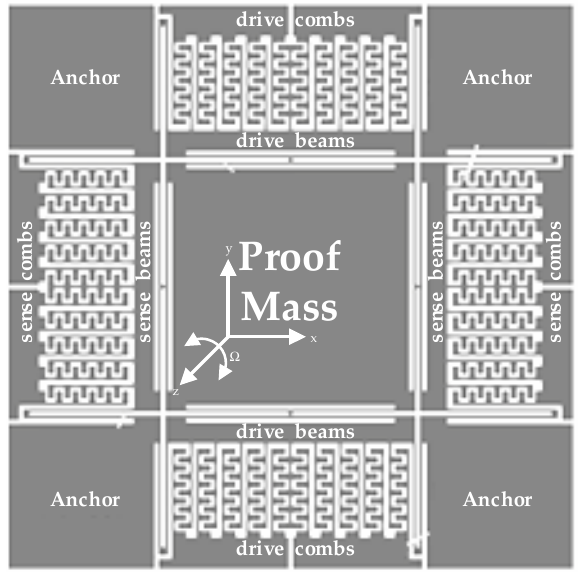
Figure 2. A standard model of the sensitive structure for MEMS gyroscopes.